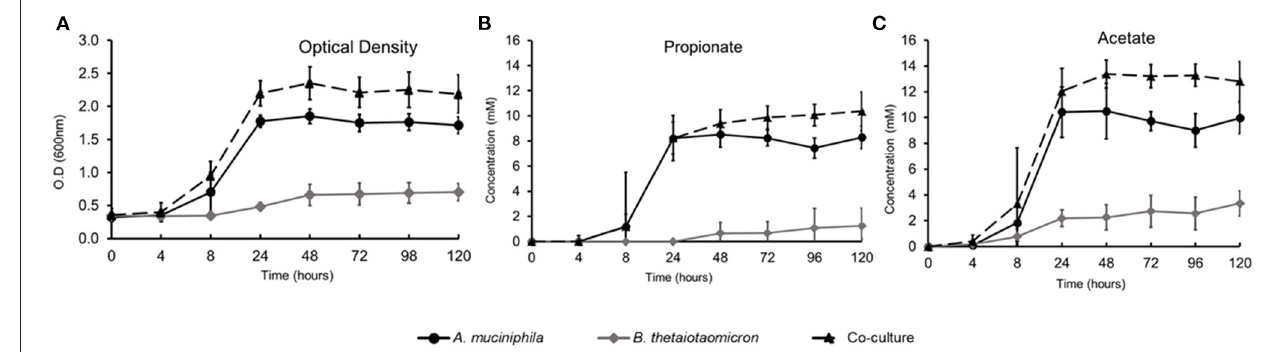
FIGURE 1 | Growth and SCFAs production during in vitro fermentation. (A) Optical Density (O.D.) measurements at 600nm, (B) Propionate production, (C) Acetate production.